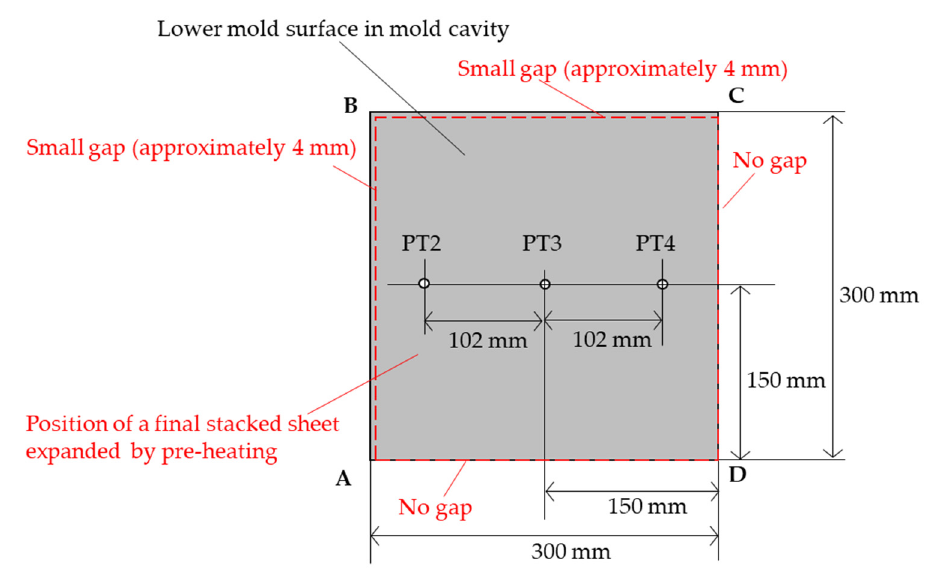
Figure 4. Positions of the pressure–temperature in-mold sensors and a final stacked sheet on the lower mold. (The corner symbols A, B, C, and D correspond to those of the molded plate shown in Figure 3).